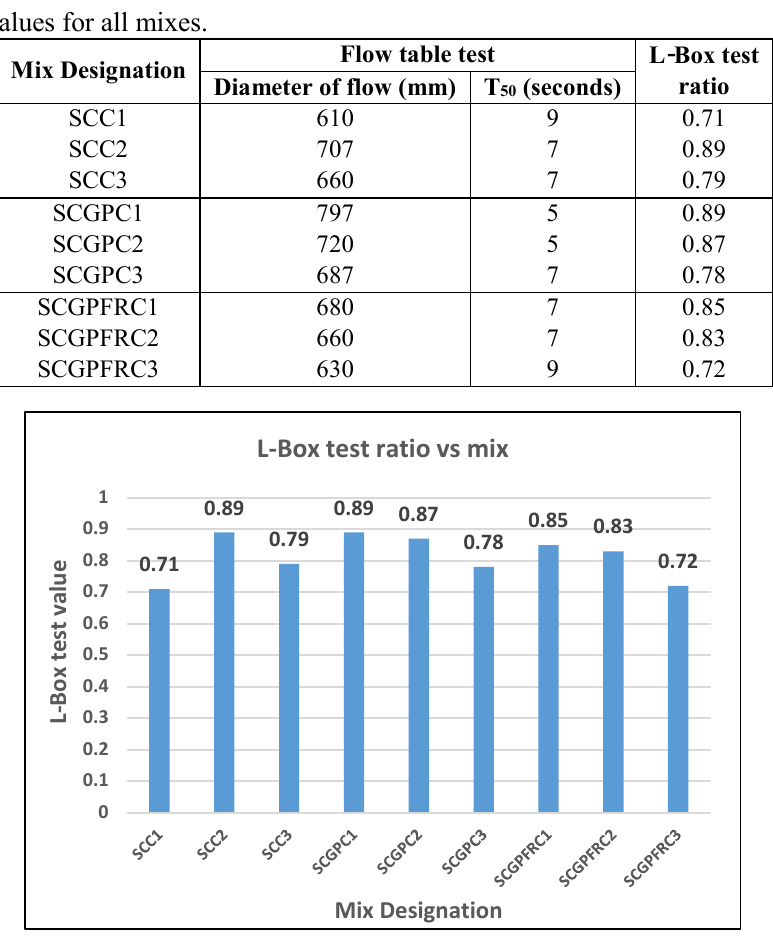
Fig. 3. Graph showing the variation of diameter of flow for all the